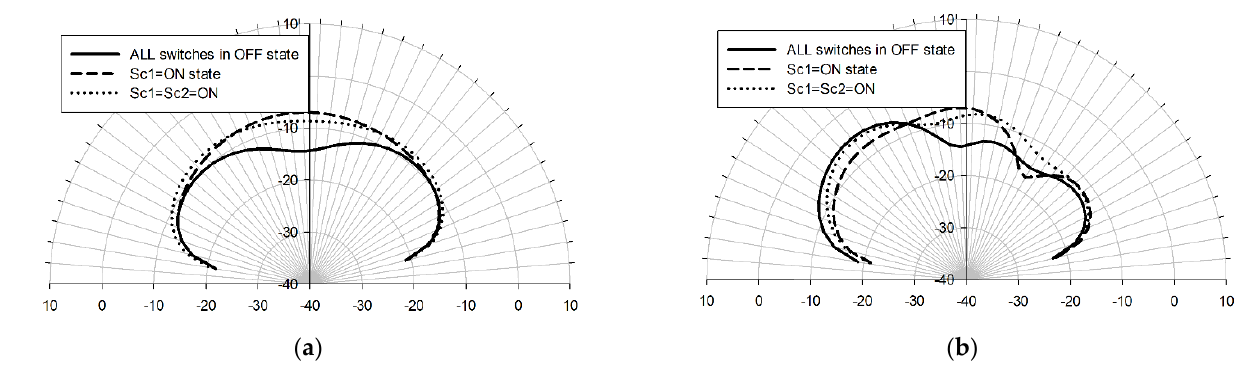
Figure 8. E-plane (xz-plane) ( a ) and H-plane (yz-plane) ( b ) radiation patterns (realized gain) when all of the switches are OFF (solid line), Sc1 = ON (dashed), and Sc1 = Sc2 = ON (dotted) at 50 THz. The simulations were done with the Sonnet Professional software.